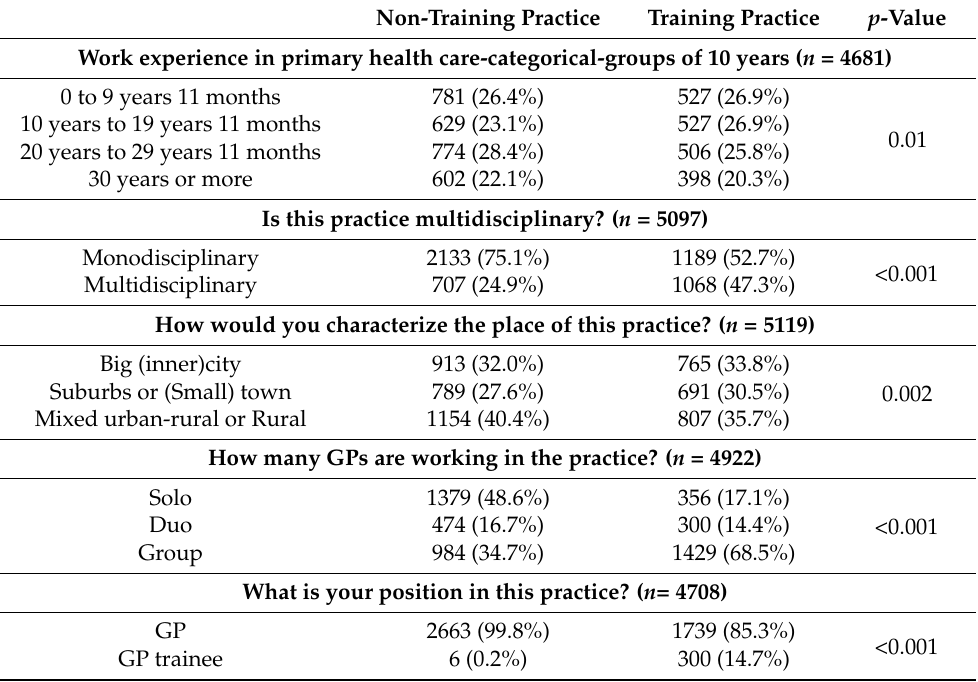
Table 3. Distribution of covariates among training and non-training practices. Non-Training Practice Training Practice p